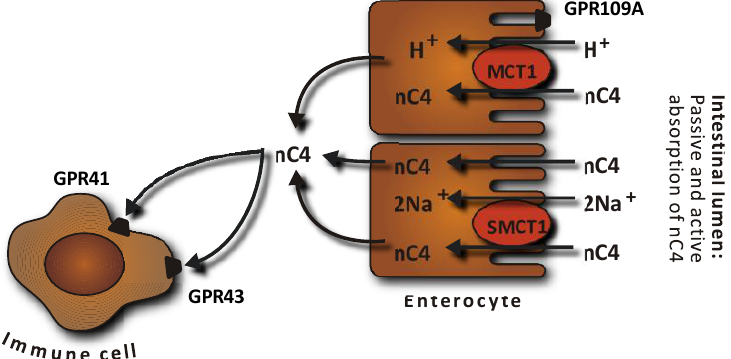
Figure 2. Absorption of butyrate (nC4) in the large intestine. Butyrate transport with monocarboxylate transporters (MCT) is saturable and coupled with H + transport. Several G-protein-coupled (GPR) receptors for butyrate have been identified and detected in various tissues including the colonic epithelium (GPR109A) and immune cells (GPR41 and GPR43). SMCT, Na-coupled monocarboxylate transport. Modified from [54].